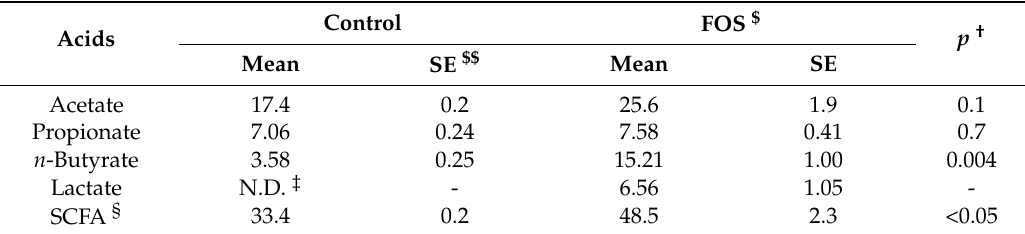
Table 2. Concentration of organic acids in cecal contents at eight weeks after feeding (mmol/kg digesta). Control Acids